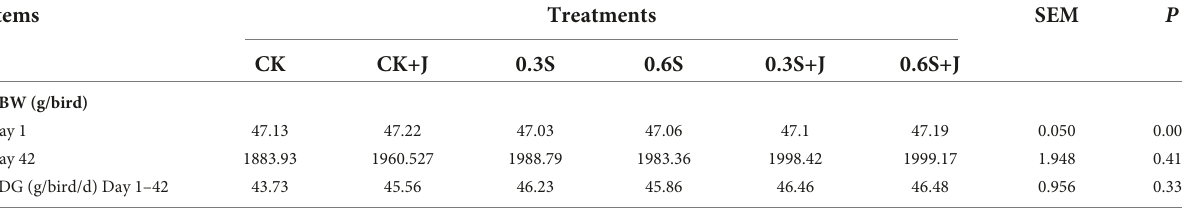
TABLE 3 Effect of dietary selenium yeast and jujube powder supplementation on growth performance of white feather broiler.